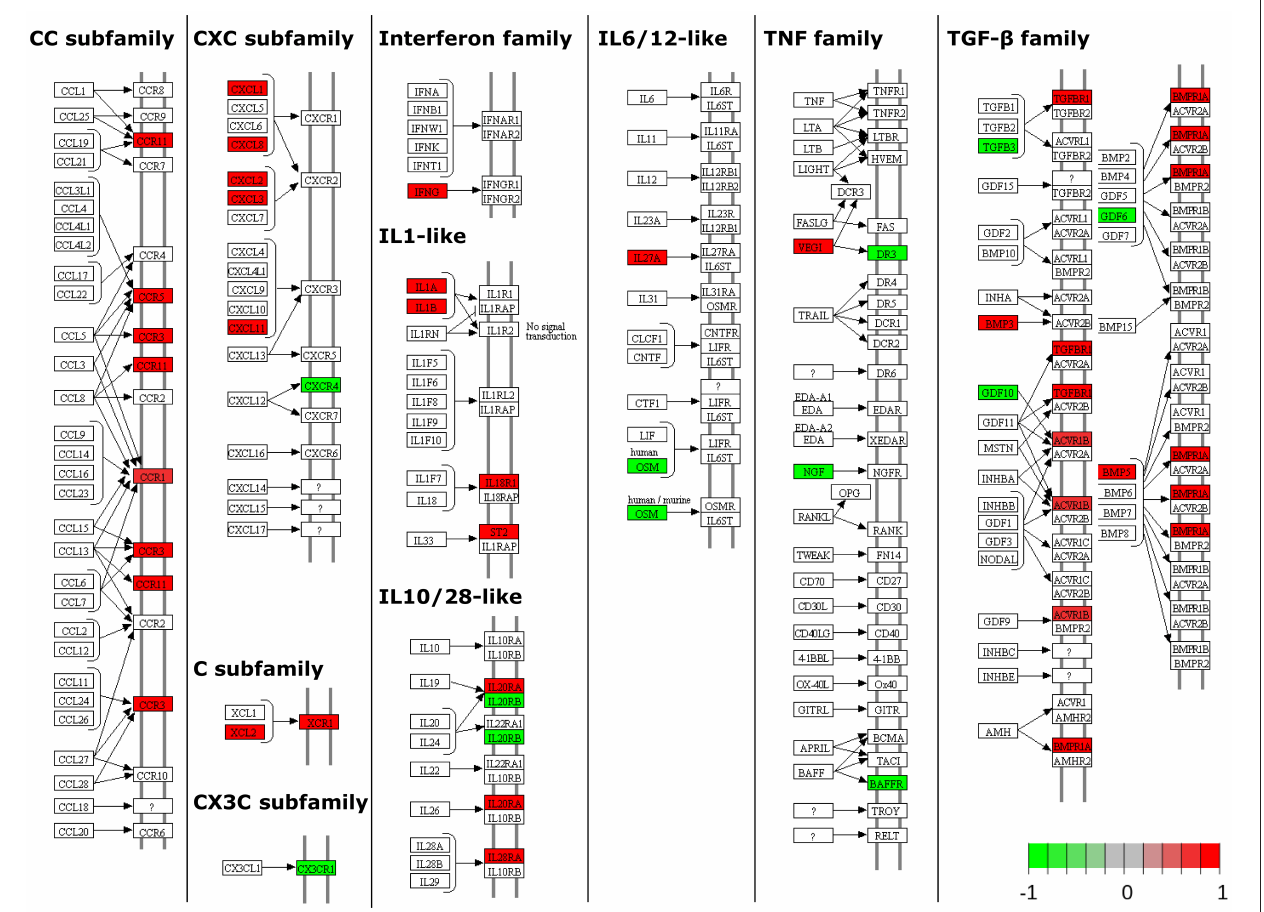
FIGURE 4 | Pathway-based visualization of differentially expressed genes encoding cytokines and chemokines and their receptors when comparing MAP-infected DPP to PBS control intestinal segments. Data was rendered using Pathview (63). Red, upregulated; green,